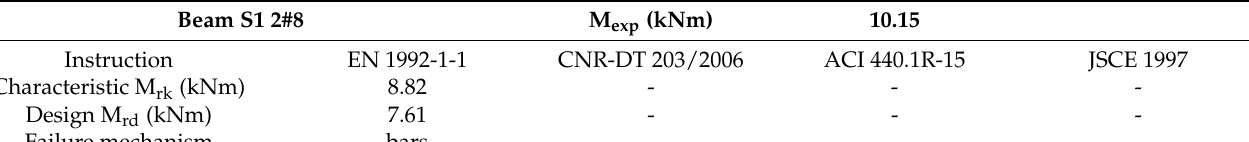
Table 4. Calculation of beams for different